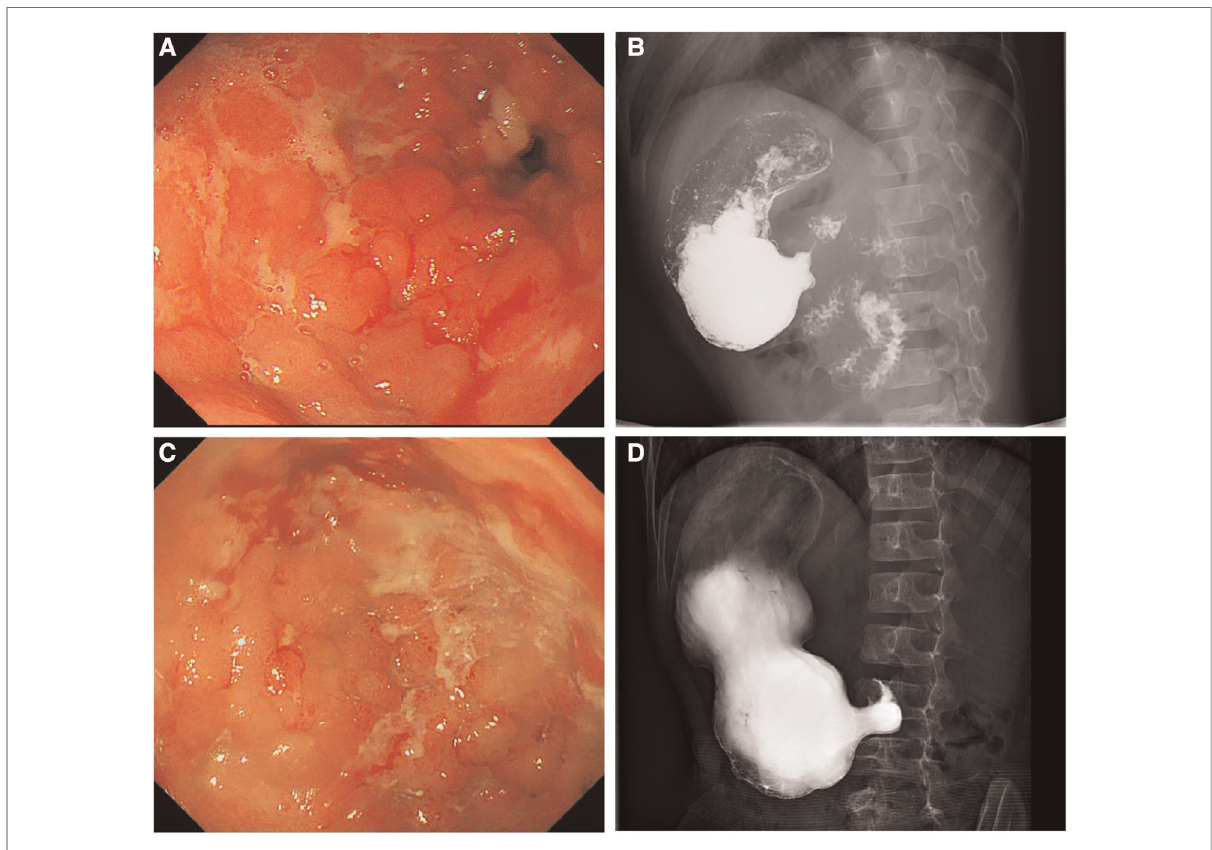
FIGURE 2 Esophagogastroduodenoscopy (EGD) showing edema, erosion, multiple ulcers, and pyloric stenosis of the stomach at 7 ( A ) and 12 ( C ) years old. Upper gastrointestinal radiography showing gastric retention and pyloric stenosis at 7 ( B ) and 12 ( D ) years